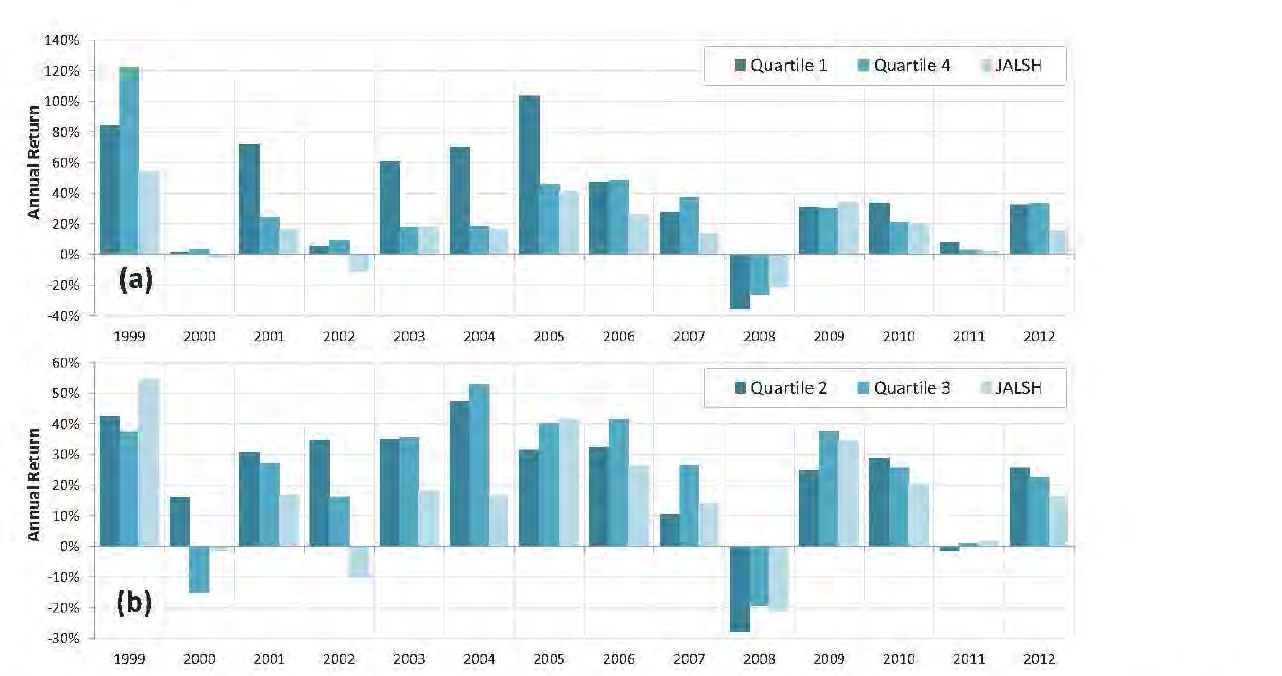
Figure 2: Portfolio and JALSH returns by year for value and growth stocks based on PIE, 1999-2012 for (a) quartiles 1 and 4 and (b) quartiles 2 and